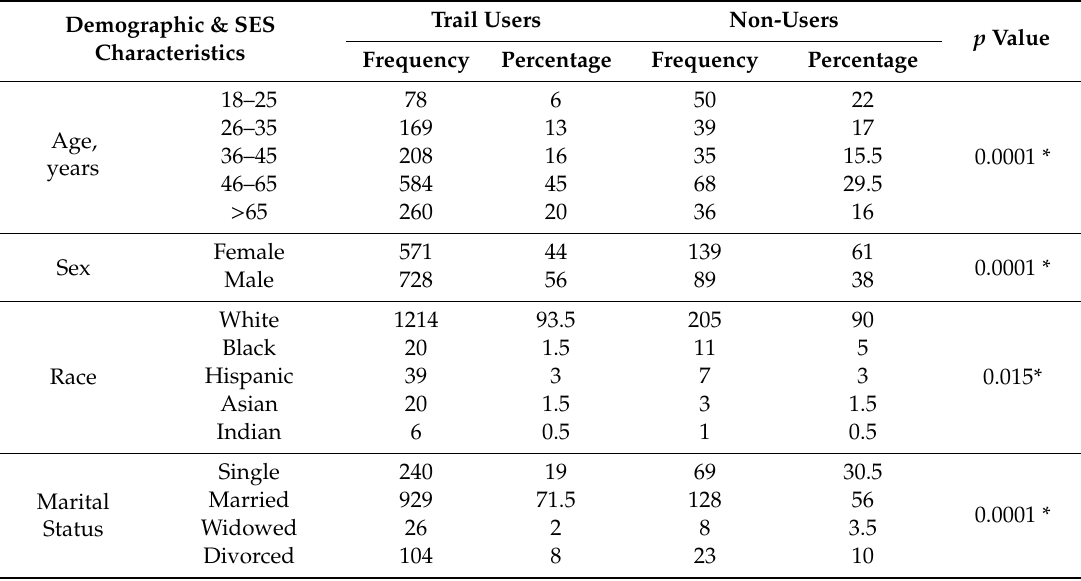
Table 1. Demographics and socioeconomic status information of trail users vs. trail